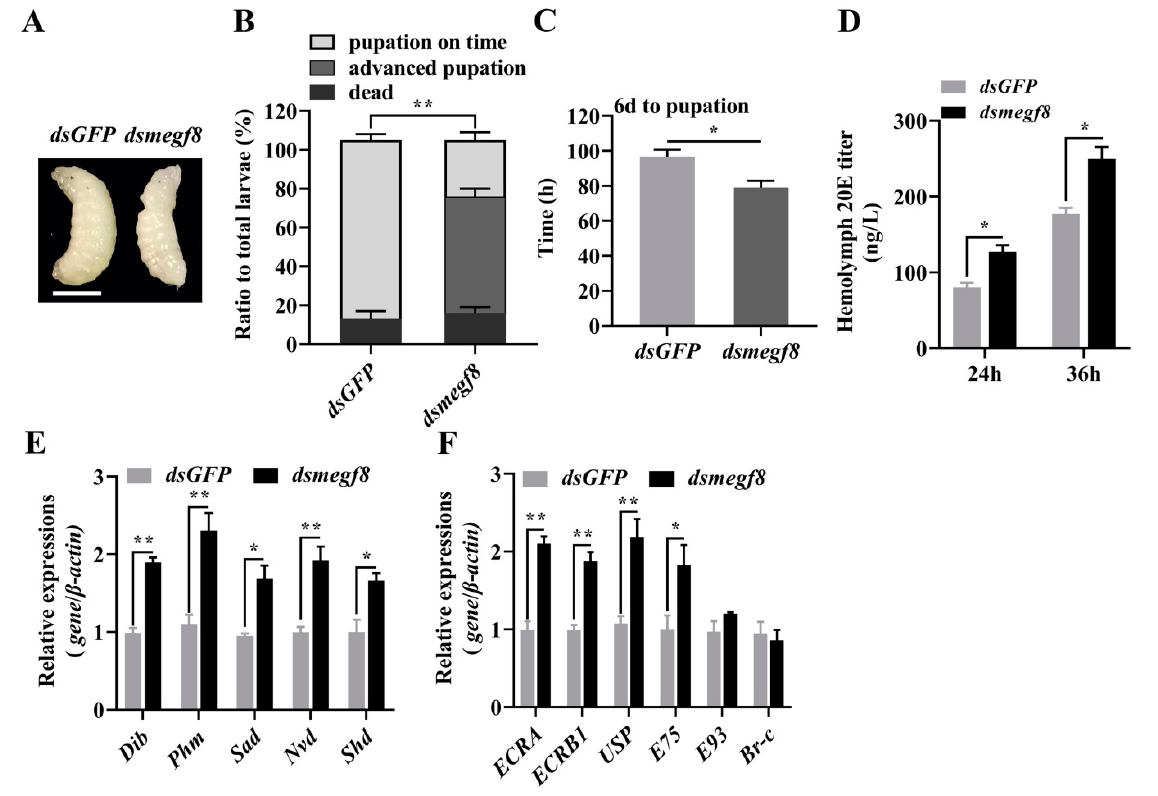
Figure 9. Injection of dsRNA from megf8 by the six-day old larvae inhibits ecdysteroid synthesis and represses 20E signal in A . mellifera . ( A ) Phenotypes after dsmegf8 injection; the ruler represents 0.3 cm. ( B ) Percentage distribution of different phenotypes. ( C ) Statistical analysis of the time of development of six-day old larvae to pupae. ( D ) The determination of the 20E titer 24 and 36 h after dsmegf8 injection. The expression levels of genes essential for ecdysteroid synthesis ( E ) and 20E signaling pathway genes ( F ) 24 h after dsmegf8 injection. * p < 0.05, ** p < 0.01 (Student’s t -test). Error bars indicate the mean ± SEM (n = 5).